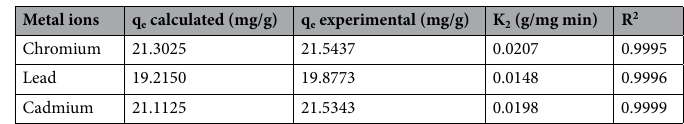
Table 4. Sorption capacities at equilibrium and sorption rate